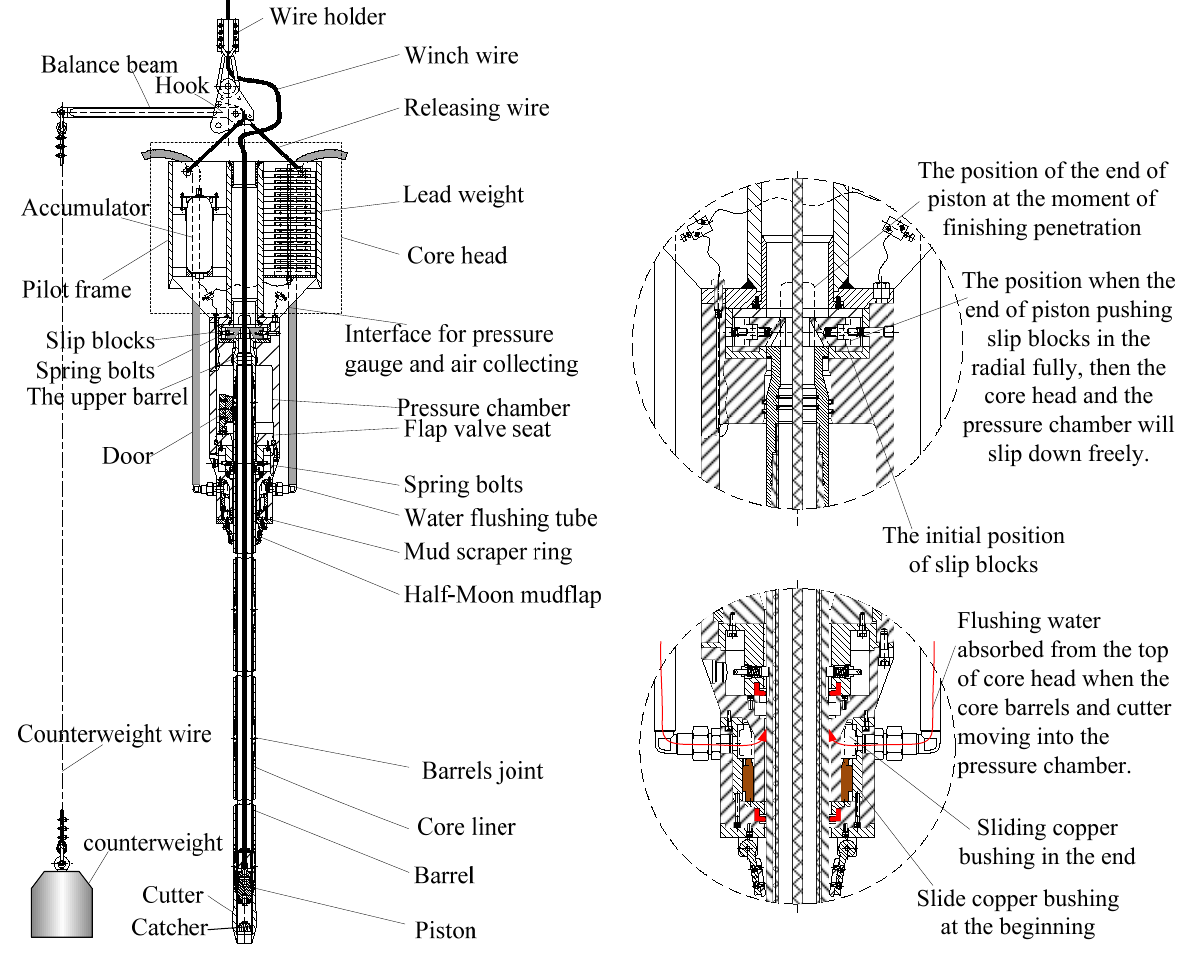
Figure 1. Components of the long pressure-retained gravity-piston corer.